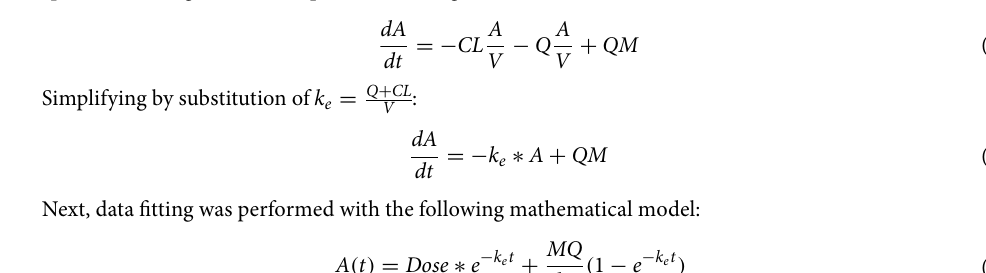
sity of delineated whole-body contours present in the fluorescence images (Figs. 1, 2, 3, 4, 5, 6, 7). Fluorescent images obtained after IY microinjections were not analysed as in most cases no redistribution of the compound could be observed across the zebrafish eleuthero-embryos. The total measured fluorescence was proportional to total amount of compound present in the animal, as described by Eq. (1). RFU T denotes the sum of fluorescence intensity in the overall image, A denotes the amount of drug in the zebrafish, and FLUOR is a constant denoting the compound-specific fluorescence quantum yield.